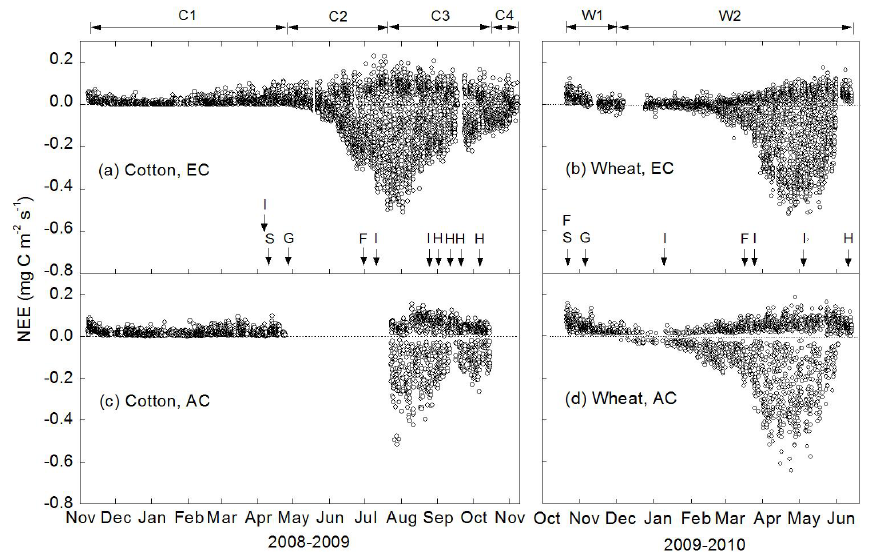
Fig. 4. Half-hourly net ecosystem exchange (NEE) measured using the eddy covariance (EC) and automatic static chamber (AC) techniques in the cotton and wheat fields. The arrows with “S”, “G”, “F”, “I,” and “H” indicate the dates of sewing, germination, fertilization, irrigation and harvest, respectively. Table 1. The cumulative NEEs (gCm − 2 ) and the relative uncertainties (%) derived from the measurements using the automatic chamber (AC) and eddy covariance (EC)